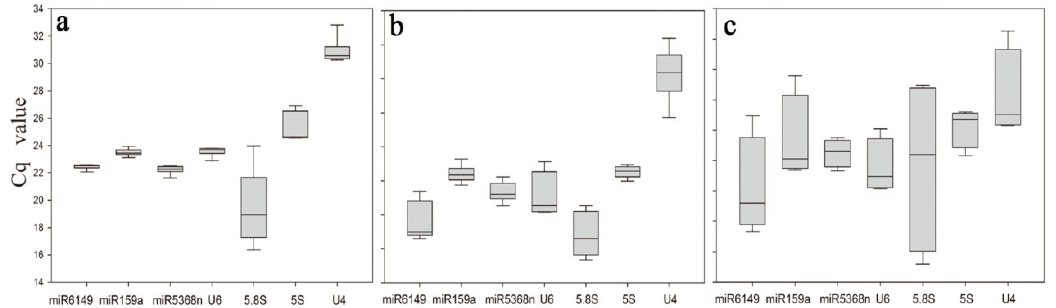
Figure 1. Box plots of the Cq values of different candidate reference genes among samples. ( a ) Expression data for seven candidate reference genes in tea plant leaves treated by E. oblique attack, mechanical wounding, MeJA, SA and ABA, respectively; ( b ) Cq values of seven candidate reference genes among six samples of the bud to the fifth leaf in tea plants; ( c ) Cq values (y-axis) of seven candidate reference genes of flowers, fruits, roots and young leaves in tea plants. Lines across boxes show the median, boxes show 25th and 75th percentiles and whisker caps show the maximum and minimum values and outliers.